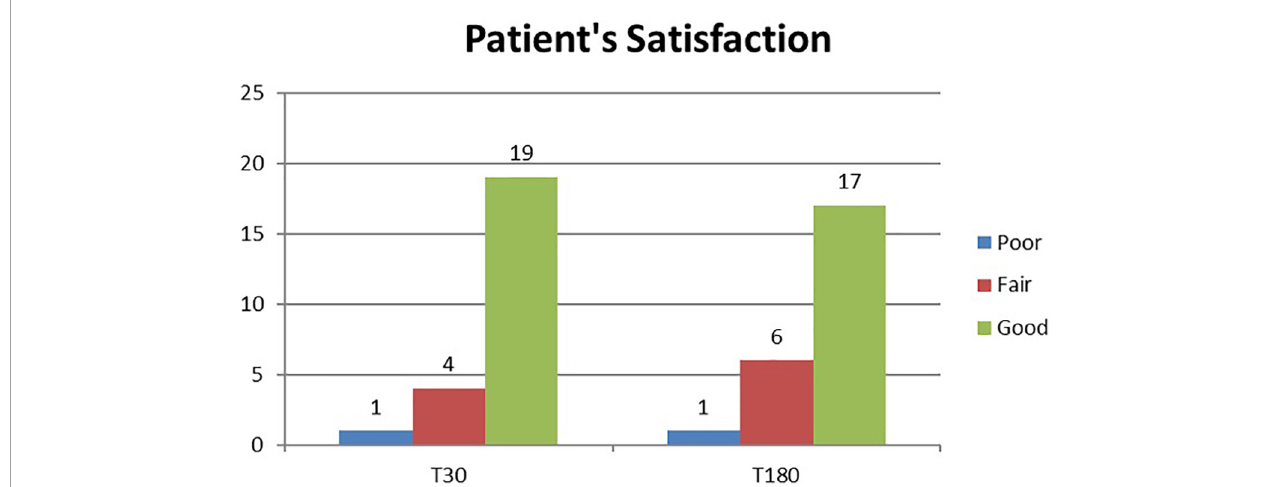
FIGURE2 Histogram representation of patient satisfaction assessment results at study follow-up visits (T30 and T180).